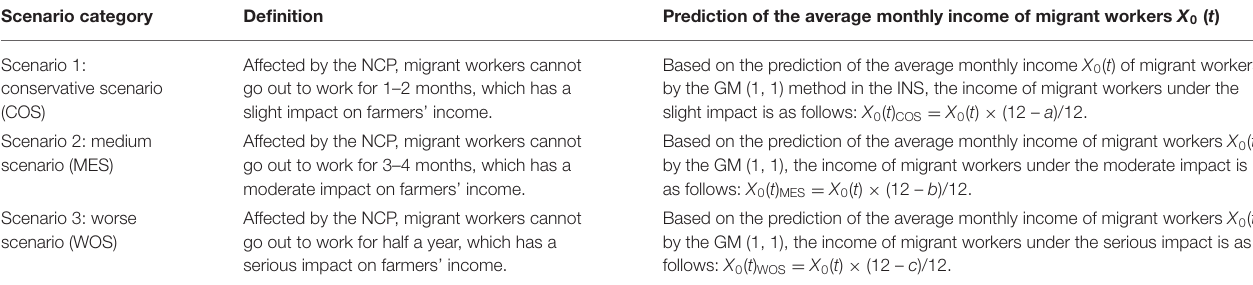
TABLE 1 | The average monthly income of migrant workers under different scenarios. Definition Prediction of the average monthly income of migrant workers X 0 ( t